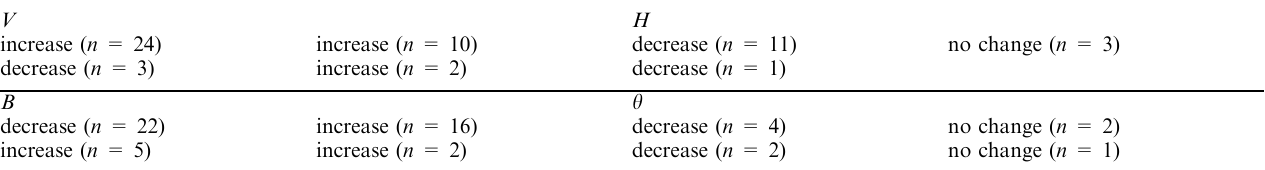
Table 2. Classification of 27 GOES 6 events during 2100–0100